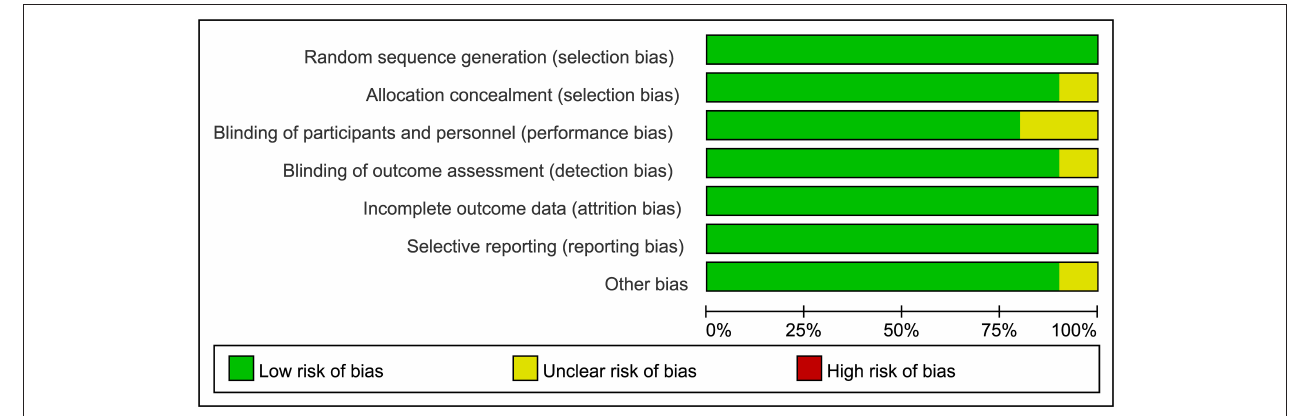
FIGURE 2 | Risk of bias analysis.